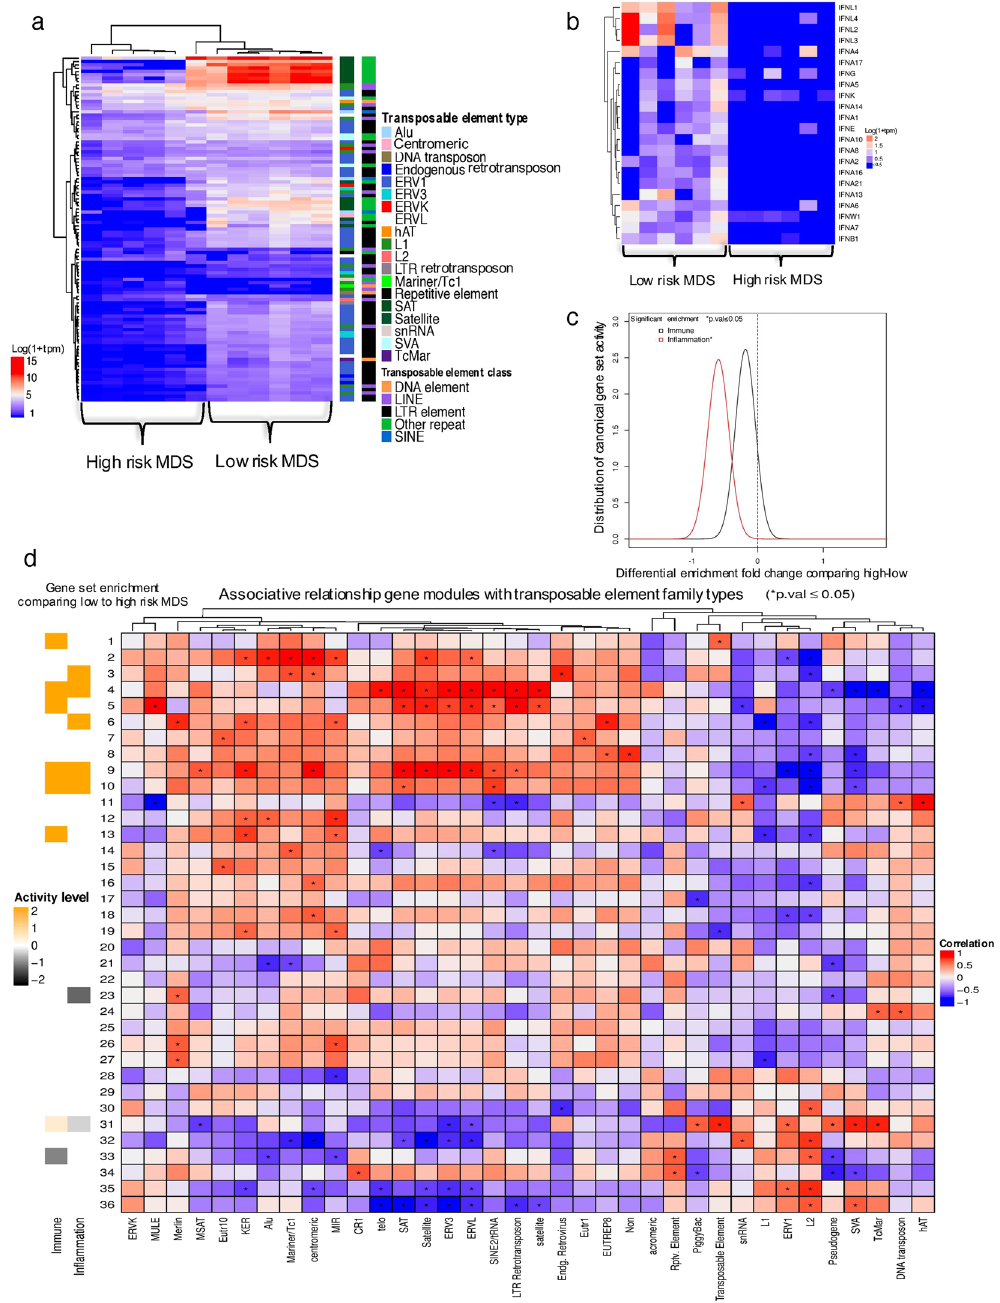
Figure 5. Expression of transposable elements in myelodysplastic syndrome (MDS) (a) Differential TE expression between low- and high-risk MDS cases. The legends showing TE type and class are identical to Fig. 1a. (b) Expression of type-1 interferon genes in MDS using log 10 TPM. (c) Comparison of high- and low-risk MDS cases for enrichment of canonical immune and inflammation gene sets, similar to Fig. 2b. (d) Identification of significant association between the expression of coding gene networks and TE types in MDS, similar to Fig.